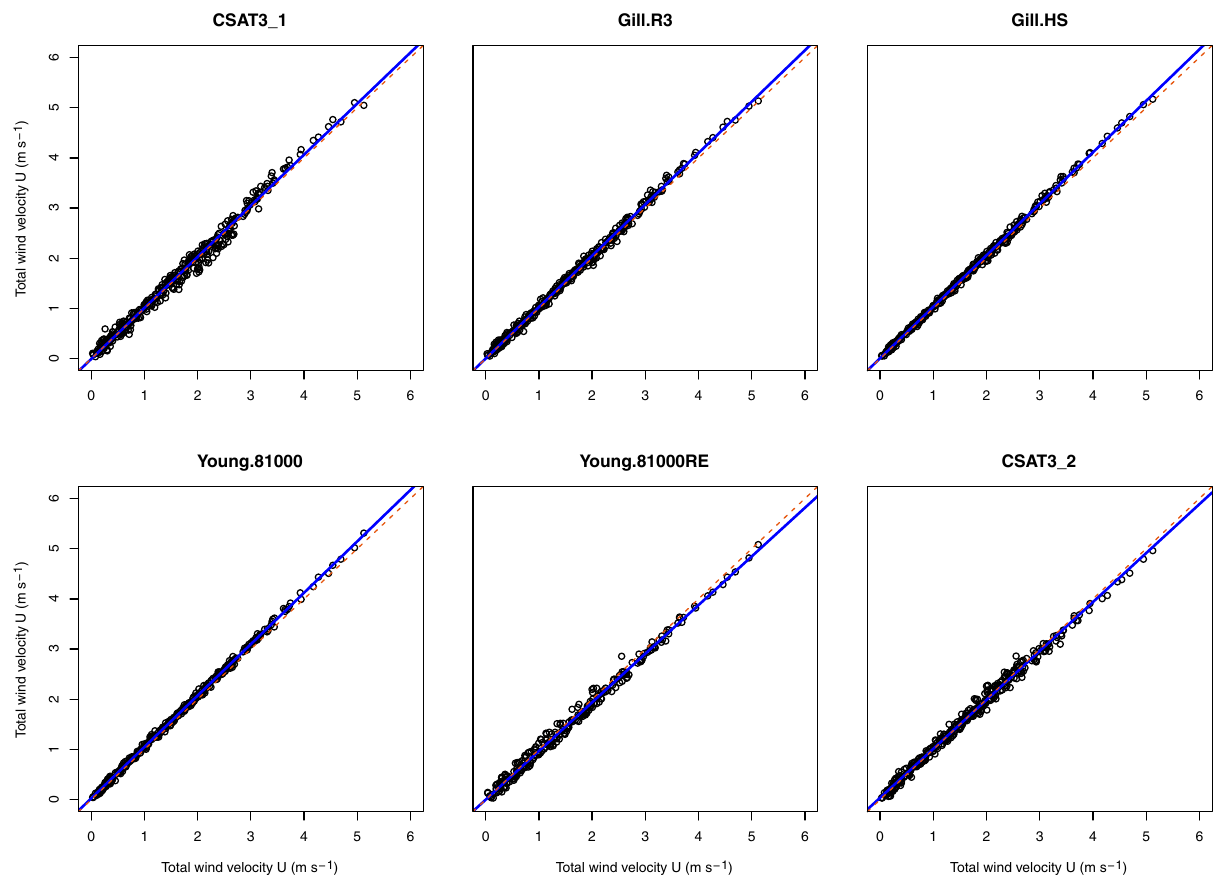
Figure 4. Comparison of the 30min averaged total wind velocity measurements (etalon = METEK.uSonic.omni). Table 2. Regression results for the comparison of mean total wind velocity U , plus estimates for bias and comparability (RMSE). Etalon = METEK.uSonic3.omni